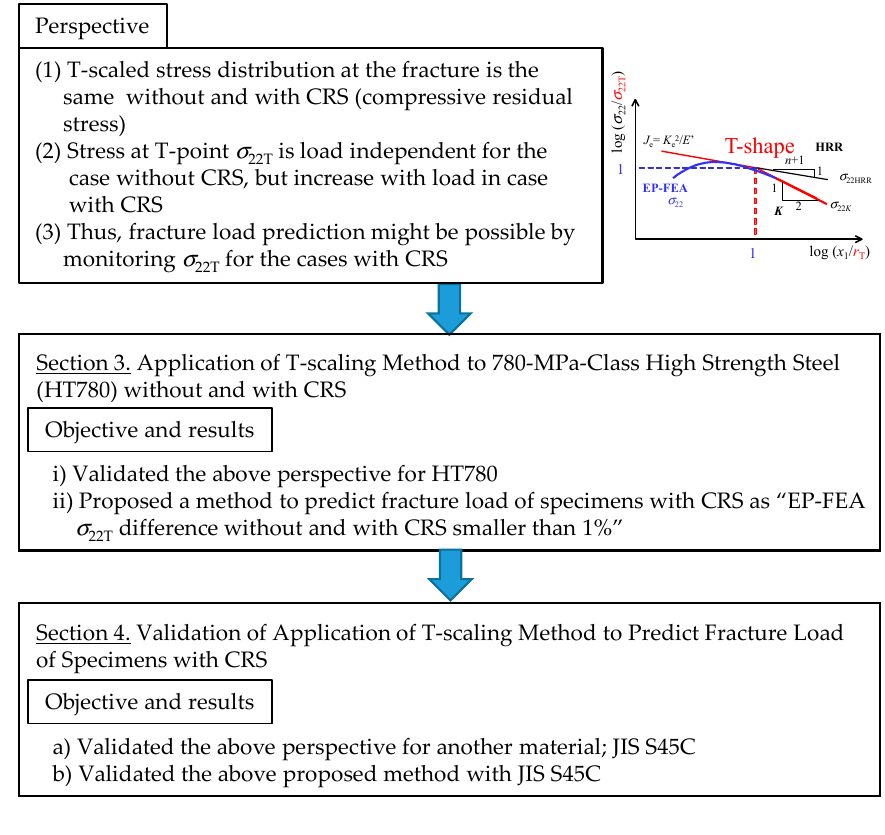
Figure A1. Constitution of this manuscript.